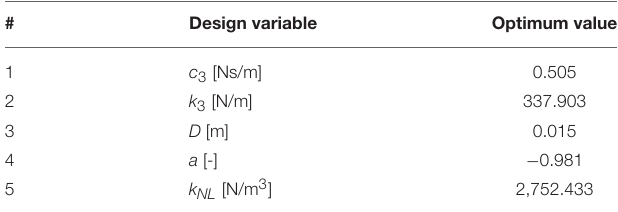
TABLE 5 | Optimum parameter values for the HNES device with stroke constraint S d < 0.5 m ( (cid:12) (cid:12) (cid:12) (cid:12)